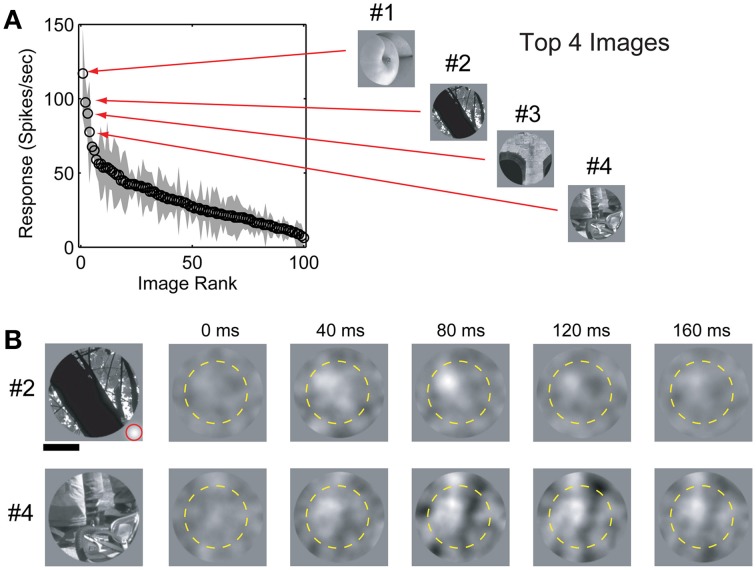
Image selection and spike-triggered masks. (A) Response (mean ± std) of a single V4 neuron to a set of 100 randomly selected natural scene images sorted by firing rate. #1–#4 indicates the four “top” (maximal evoked response) images. Spike-triggered masks were estimated for the top 4 images. (B) Spike-triggered masks from the same cell for images #2 and #4 in (A). The dashed yellow circle indicates the RF position and size (see text for details). Scale bar indicates 0.5 degree and the size of an individual Gaussian window is indicated (red circle) in the lower right corner of image #2.